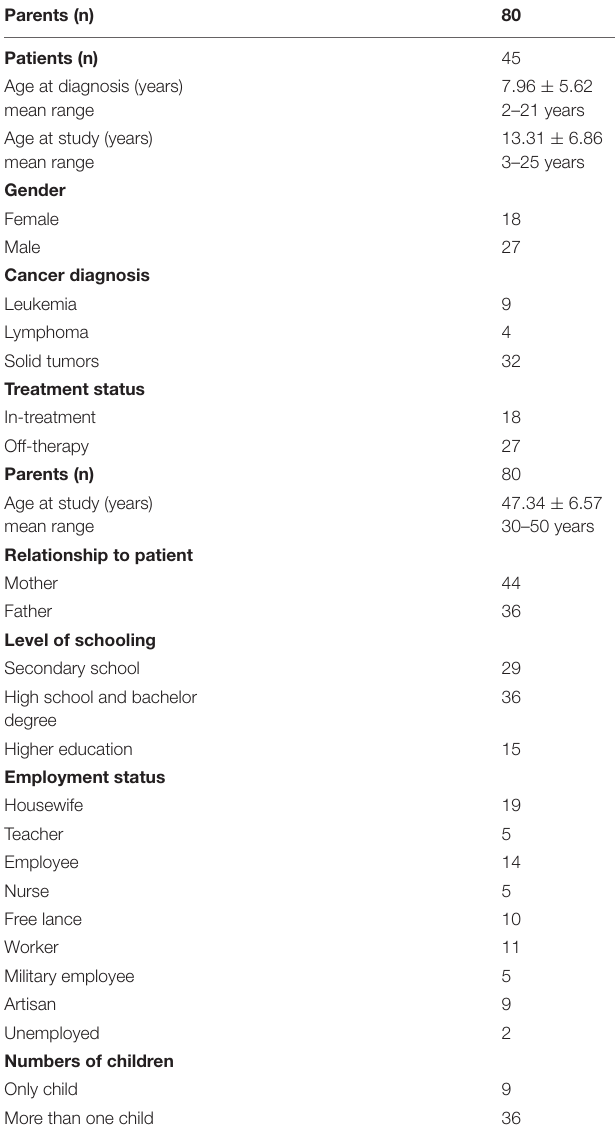
TABLE 1 | Demographic and clinical